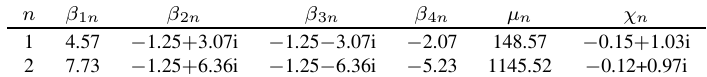
Table 1 The roots of Eq. (24) and μ n, χ n calculated from Eq. (34)